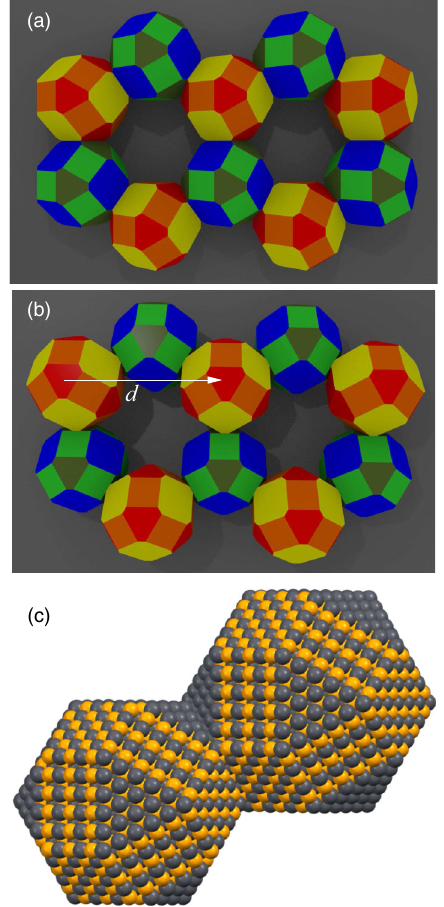
FIG. 1 (color online). (a),(b) Block models for the self- assembled honeycomb lattices based on nanocrystals that have a truncated cubic shape. (a) Honeycomb lattice formed by atomic attachment of three of the 12 f 110 g facets (light green and orange regions) corresponding to a graphene-type honeycomb structure (both sublattices in one plane). (b) Honeycomb lattice formed by attachment of three of the eight f 111 g facets (dark green and red regions), leading to the silicene-type configuration (each sub- lattice in a different plane). In both models, a h 111 i direction is perpendicular to the honeycomb plane, as is experimentally observed. The arrow indicates the superlattice parameter d . (c) Top view of the unit cell of a graphene-type honeycomb lattice of PbSe nanocrystals. (The Pb atoms are represented by gray spheres, the Se atoms by yellow different parallel planes, in analogy with atomic silicene [Fig. 1(b)]. The separation between the two planes is ffiffiffi p 6 d= ð 2 Þ ≈ 0 . 2 d , where d is the superlattice parameter defined in Fig. 1(b). The unit cell of a typical graphene-type honeycomb lattice of PbSe nanocrystals is displayed in Fig. 1(c), in the case where polar f 111 g facets are terminated by Pb atoms. We have also considered nano- crystals with Se-terminated f 111 g facets. Further details on the lattice geometry and nanocrystal shape related to the degree of truncation are given in Appendix A.